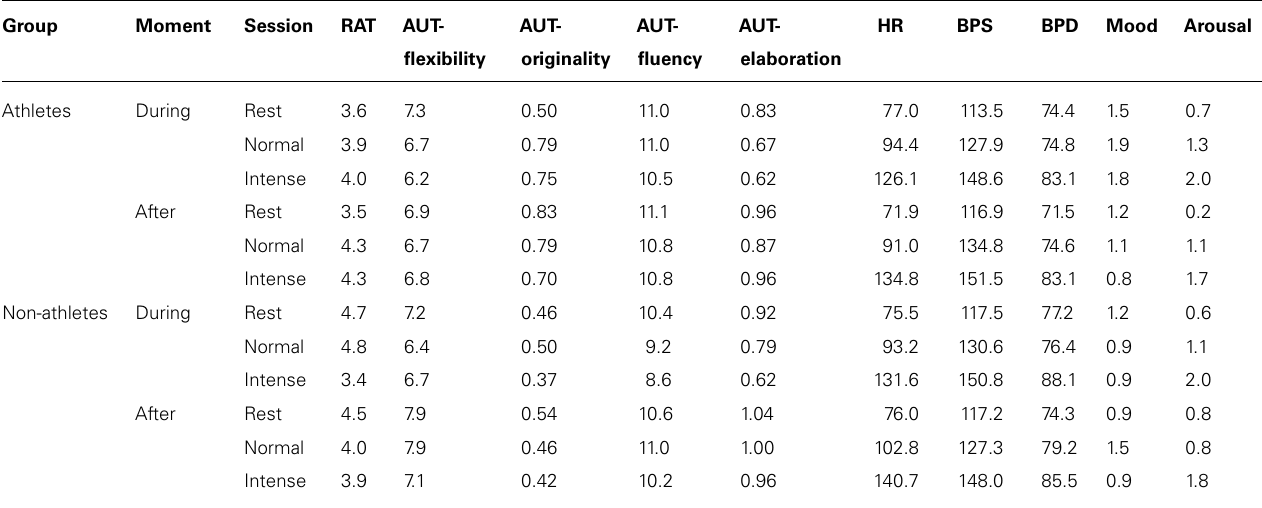
Table 1 | Means for the number of correct items from the remote associates task (RAT), for flexibility, originality, fluency, and elaboration scores from the alternate uses task (AUT), and perceived mood ratings as a function of group (athletes vs. non-athletes), session (rest vs. normal vs. intense) and moment in which participants carried out the creativity tasks (during vs. after exercise).